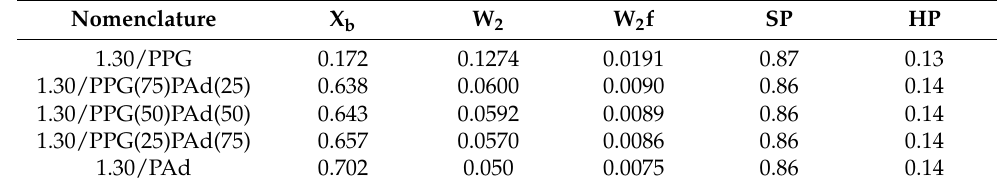
Table 3. Main parameters for determining the micro-mixing of the hard and soft phases in the